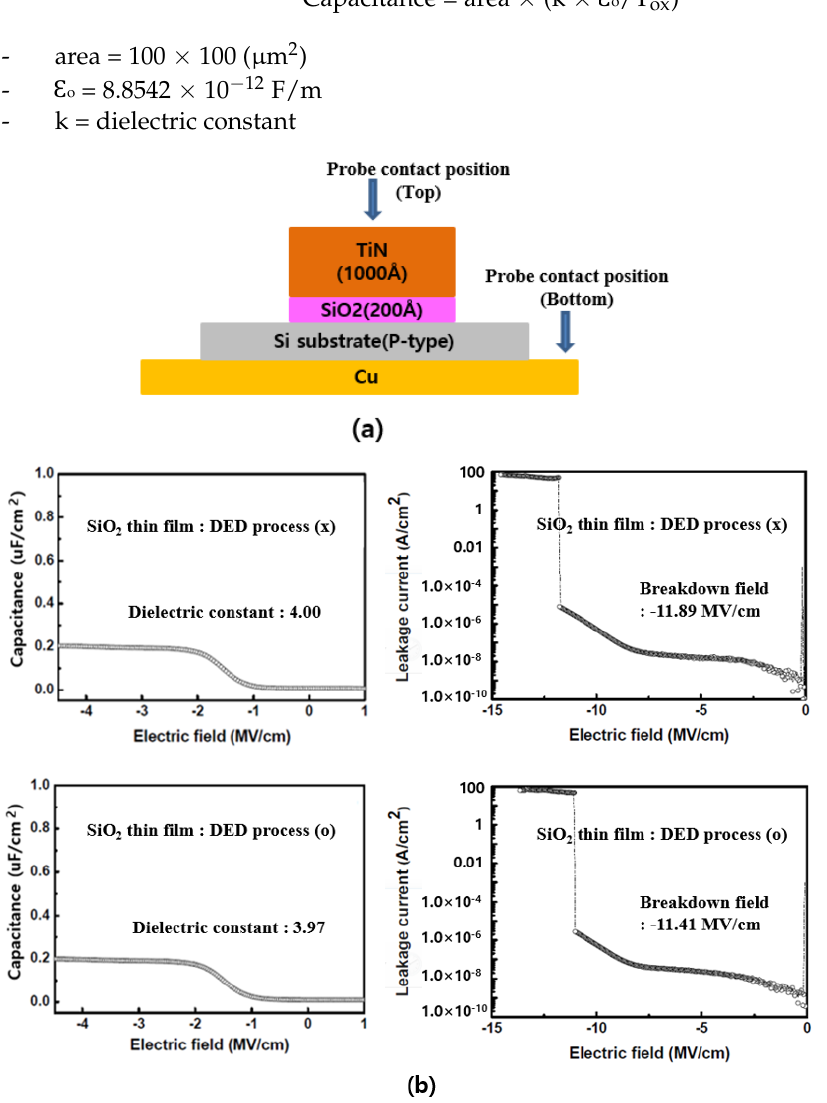
Figure 10. ( a ) Fabrication of a MOCAP device for C-V and I-V characterization and ( b ) dielectric constant and breakdown field of the deposited SiO 2 thin films. constant and breakdown field of the deposited SiO 2 thin